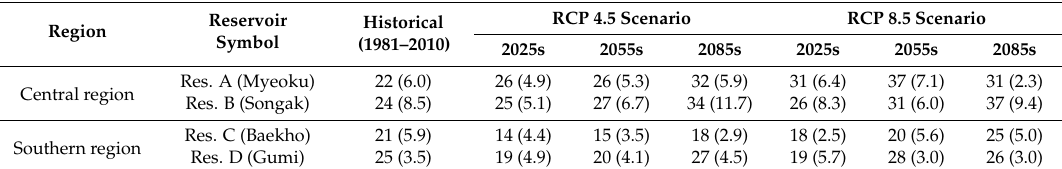
Units: average (days), standard deviation in parentheses.